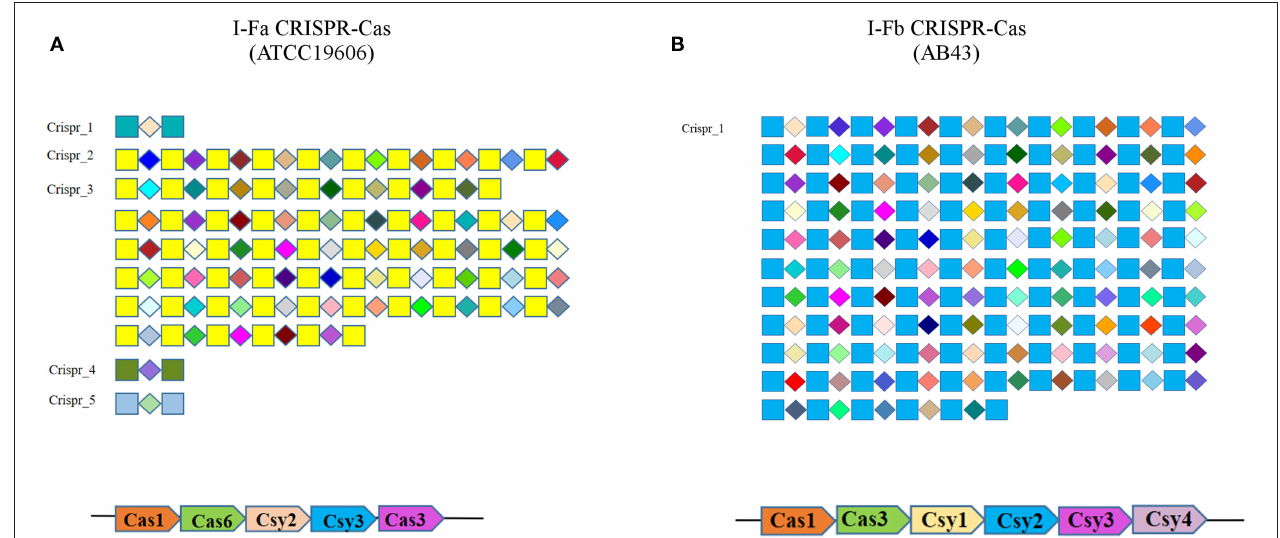
FIGURE 1 | Repeat (squares), spacer (diamonds), and the composition of different types of CRISPR-cas system of A. baumannii. (A) ATCC19606; (B) AB43.